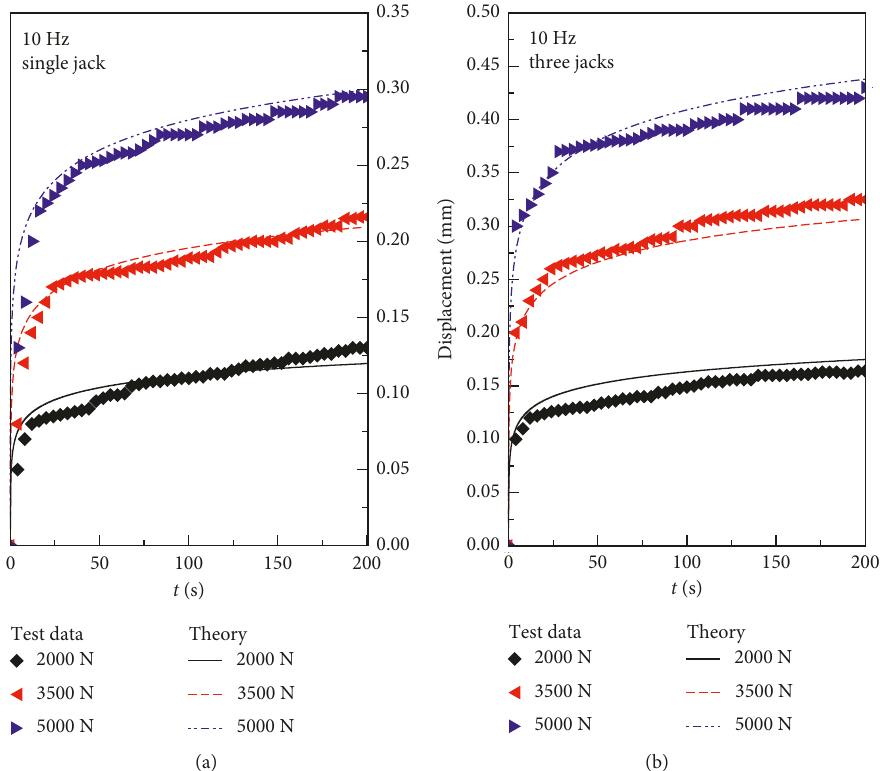
Figure 5: Displacement versus time curves under different excitation loads (sand bag): (a) single jack and (b) three jacks.